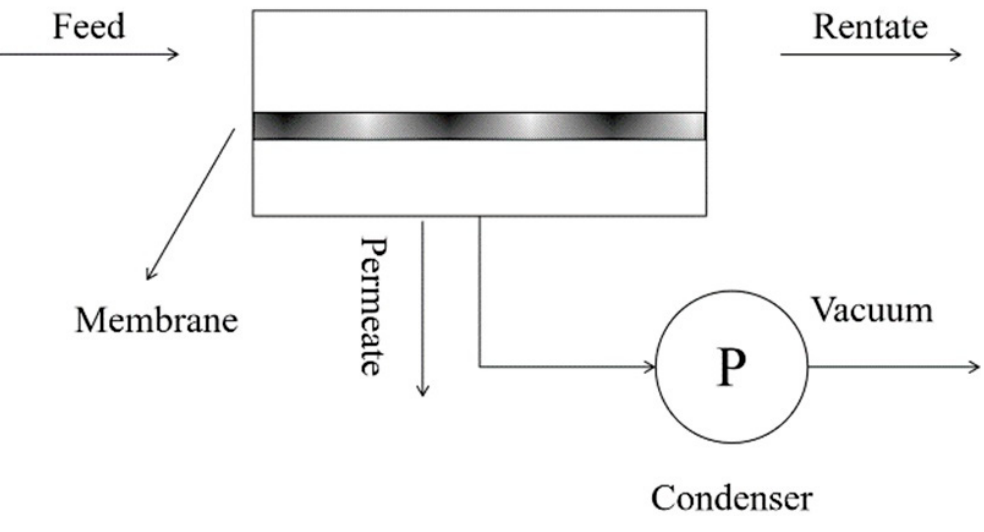
Figure 2. Graphical presentation of typical vacuum pervaporation process.